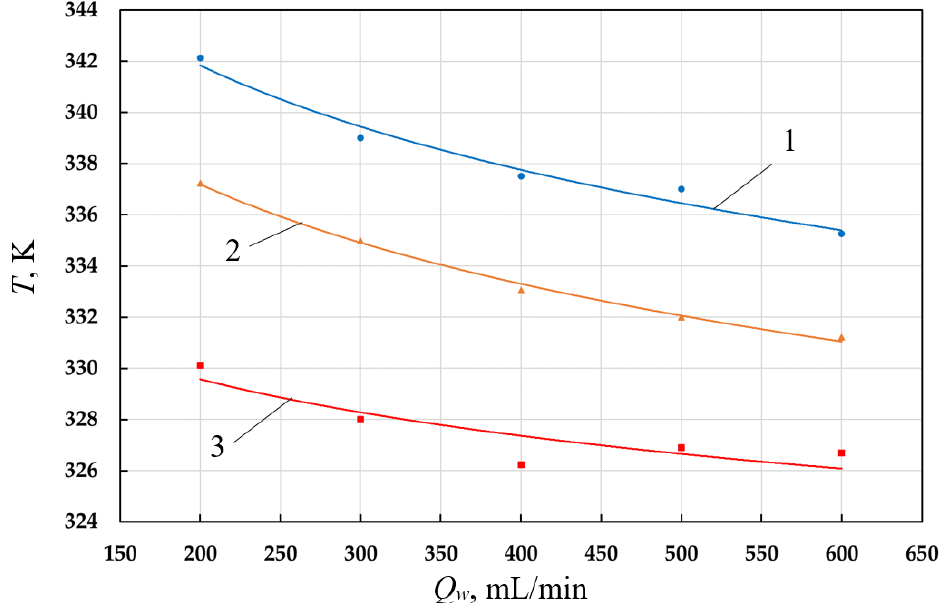
Figure 6. Dependence of cylinder wall temperature on coolant flow (1 — p d = 0.7 MPa; 2 — p d = 0.5 MPa; 3 — p d = 0.3 MPa).